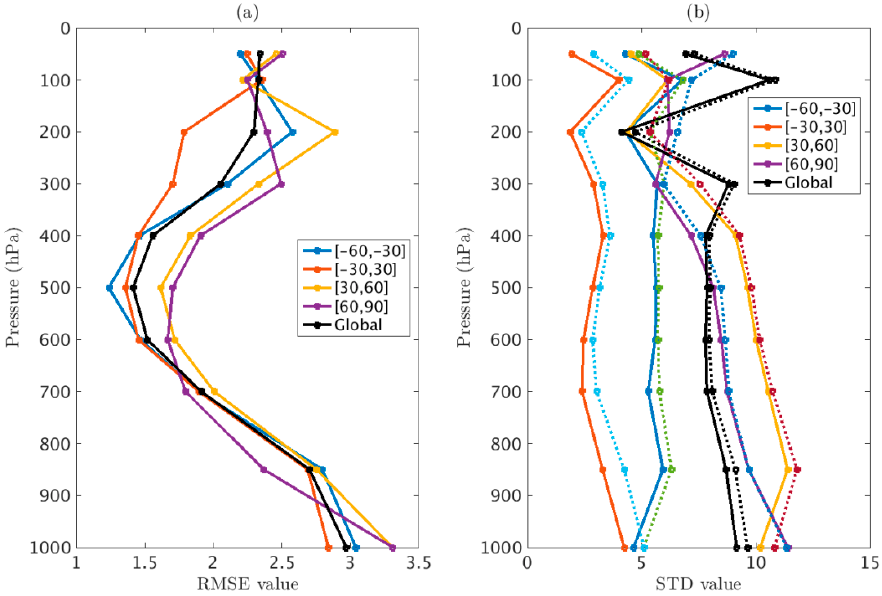
Figure 4. HIRS derived temperature (°C) compared to 2011–2012 radiosonde (1000–400 hPa) and GPS RO (300–50 hPa) profiles for global and latitude bands for ( a ) RMSE and ( b ) STD (solid lines for HIRS and dashed lines for radiosonde or GPS RO values).